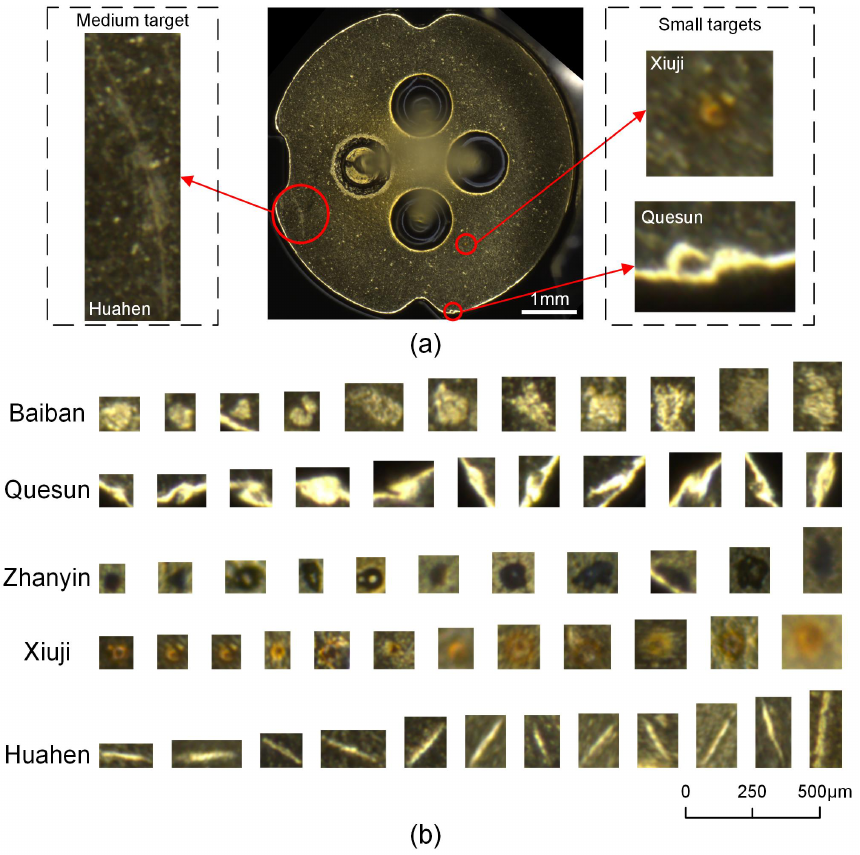
Figure 7. Example of small-target defects: ( a ) on the original image; ( b ) stored in the small-target database.